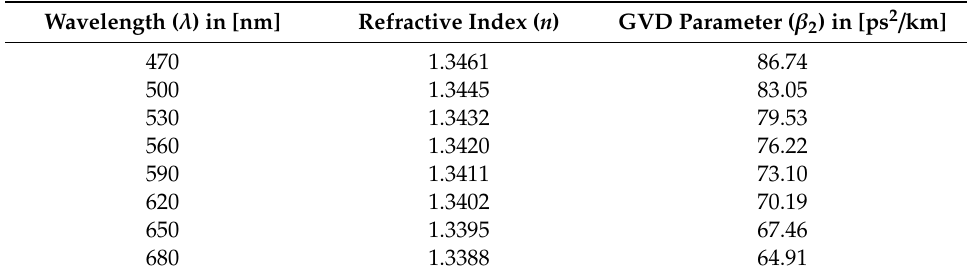
Table 1. Refractive index and GVD parameter values for various wavelengths for Sa = 35% (cid:24) , Te = 0 ◦ C and d = 100